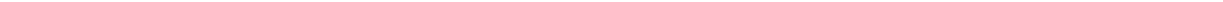
Fig. 3 Tau interacts with rDNA and regulates rDNA transcription. a Immuno fl uorescence microscopy showing γ -H2AX ( red ) and 53BP1 ( green ) labeling. Merged images in the right panel. Scale bar : 5 µ m. b γ -H2AX and Tau-1 protein levels assessed by immunoblotting. GAPDH was used as a loading control. c , d Cells were immunostained with antibodies against γ -H2AX and 53BP1. At least 400 cells were acquired, and foci counted. The number of cells ( n ) is indicated. e Mean number of PICH-coated UFBs per anaphase (at least 200 anaphase cells per condition). The signi fi cance of differences was assessed in two-tailed unpaired Student ’ s t -tests. f – i , k Cells were exposed, for 72 h, to aphidicolin ( f ), camptothecin ( g ), hydroxyurea ( h ), and CX-5461 ( i , k ). Each data point is the mean of at least three independent experiments in triplicate. j BLM, Tau-5 and CDA protein levels. β -actin was used as a loading control. l Immuno fl uorescence microscopy showing UBTF ( red ) and Tau-1 ( green ) co-localization in BS cells. Merged images ( yellow ) in the bottom panel. Scale bar : 5 µ m. m Schematic representation of a human rDNA repeat ( upper panel ). Chromatin immunoprecipitation ( ChIP ) with Tau-1, UBTF and IgG antibodies in BS cells ( lower panel ). DNA was quanti fi ed by qPCR with primer pairs covering the rDNA repeat. Their approximate positions relative to the transcription start site ( TSS ) are indicated on the x axis. Data are the means from three independent experiments. n , o Endogenous pre-rRNA ( 45 S ) levels were monitored by qPCR. B2M , β -actin , and TBP were used as housekeeping genes for normalization. The signi fi cance of differences was assessed in two-tailed paired Student ’ s t -tests. p , q ChIP with Tau-1 ( p ), UBTF ( q ), and IgG ( p , q ) antibodies. Results are obtained as described in ( m ). r , s Measurements of pools of NMPs and NTPs. Values of peak surface areas ratios between the endogenous nucleotide and its internal standard are shown. The data are the means